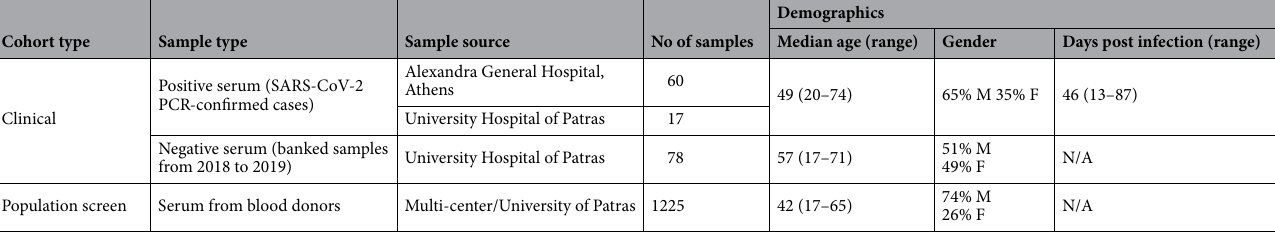
Table 1. Samples used throughout the